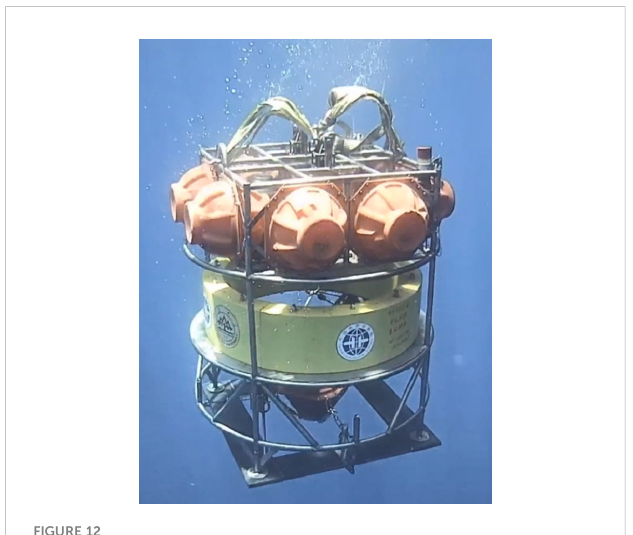
FIGURE 12 Underwater photography of